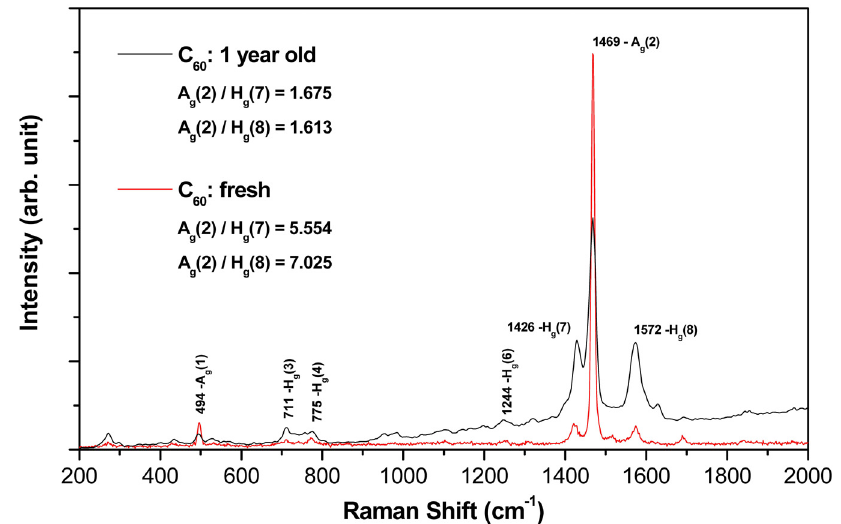
Figure 3. Raman spectra of the fresh and aged C